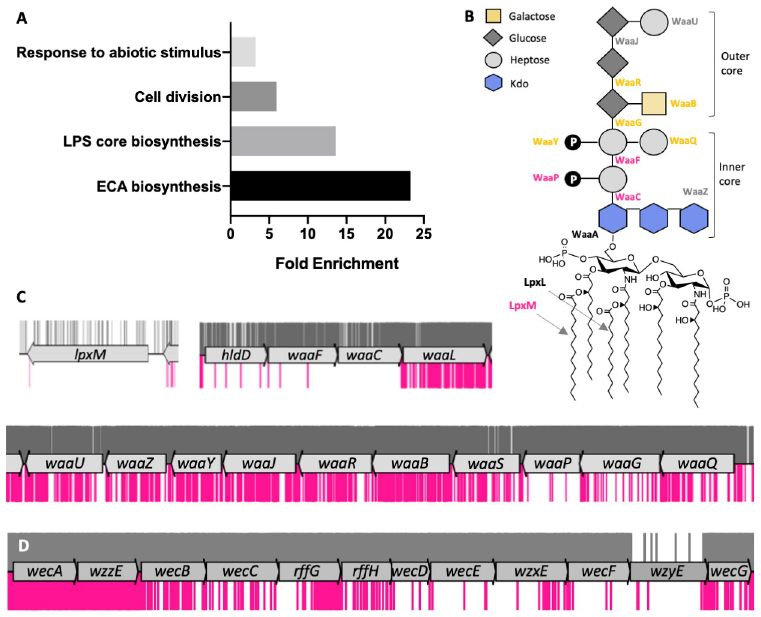
Fig 6. Functional enrichment among synthetic lethal genes. (A) Functional enrichment of cellular processes among the genes that are synthetically lethal with yhcB , with Fisher’s exact test with Bonferroni correction for multiple testing. Results displayed for P < 0.05. (B) A schematic of the structure of LPS. LPS biosynthesis enzymes are indicated next to the linkage they form (central column) or component they ligate (side branches). Synthetic lethal enzymes are labelled in dark pink, enzymes that contribute to fitness are labelled in orange, core essential enzymes in black and non- essential enzymes in grey. (C) TIS data for BW25113 (grey) and BW25113 Δ yhcB (pink) libraries were plotted above and below the gene track, respectively. Insertion sites are represented by vertical bars and are capped at a frequency of 1. Insertions within genes required for LPS core biosynthesis, and lpxM , are significantly underrepresented. (D) The insertion profiles in genes of the enterobacterial common antigen biosynthetic pathway. Abbreviations: Lipopolysaccharide (LPS); Enterobacterial Common Antigen (ECA).